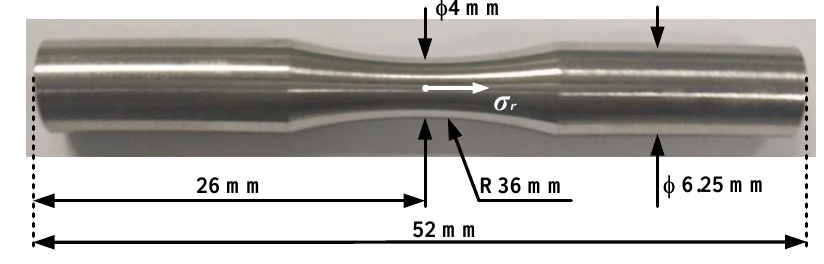
Figure 2. Geometry of fatigue specimen.